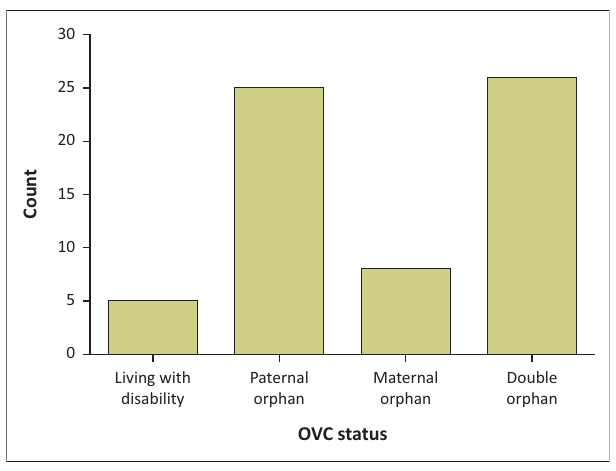
OVC, orphans and vulnerable children. FIGURE 4: Distribution of respondents’ responses on orphans and vulnerable children status.